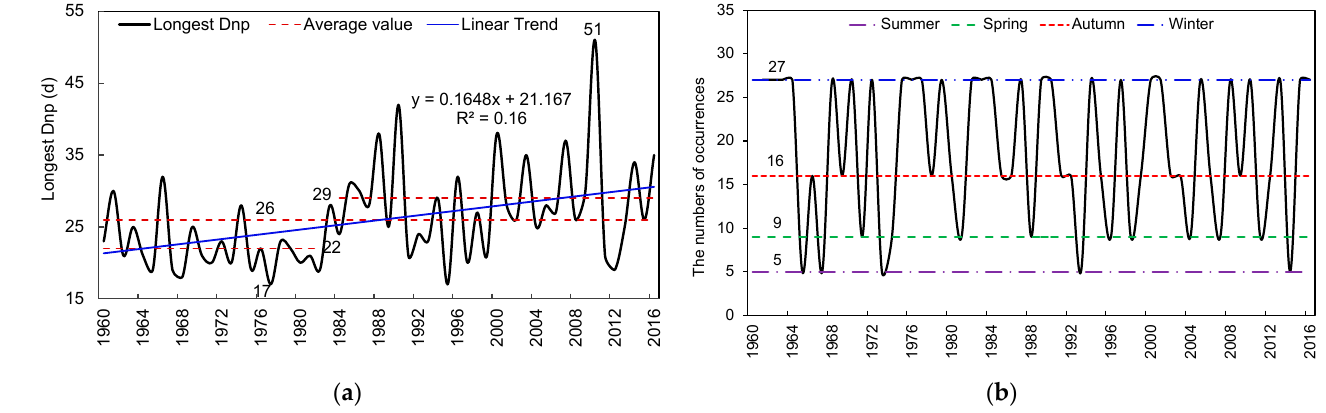
Figure 6. ( a ) Temporal variation of longest Dnp and ( b ) occurrences.